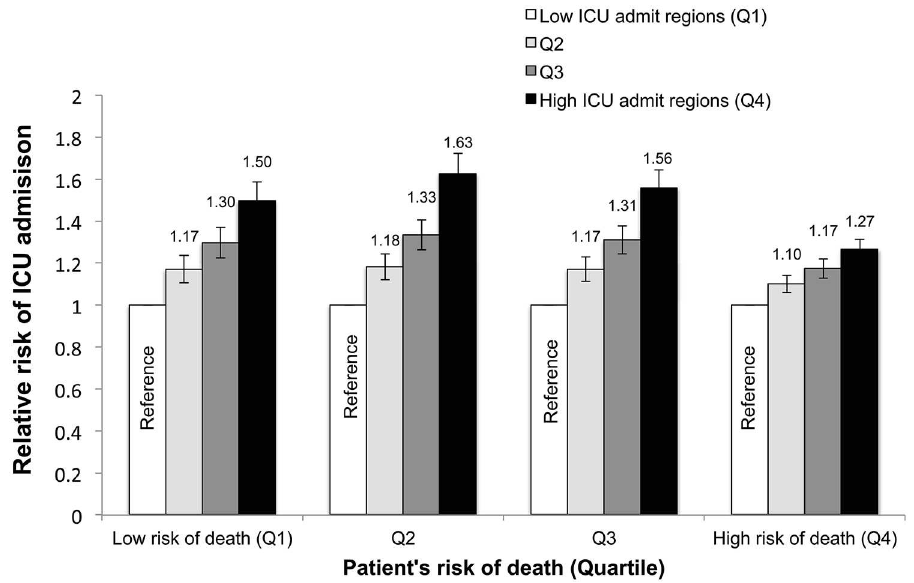
Fig 3. Association between regional ICU admission rate and patient-level risk of ICU admission, stratified by predicted risk of death. Relativerisk representsthe risk of ICU admissionfor a patient livingin a given regionrelative to a regionwith a low ICU admission